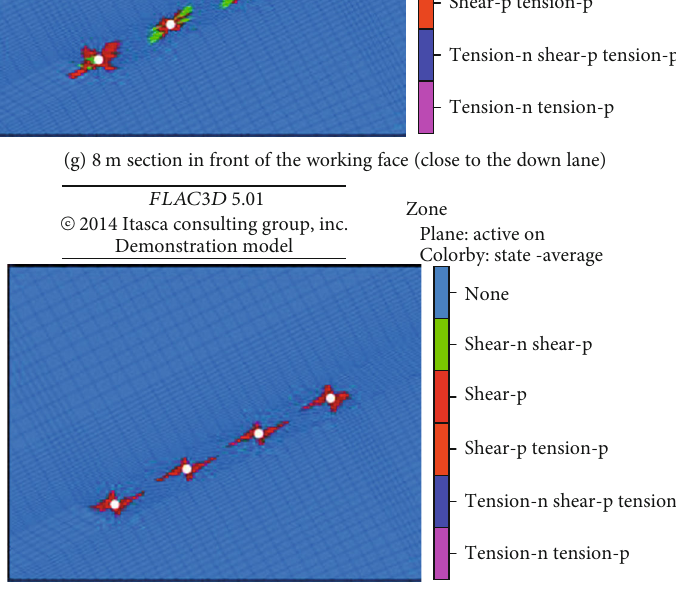
Figure 13: The distribution of the plastic zone of drilling holes along the direction of the working